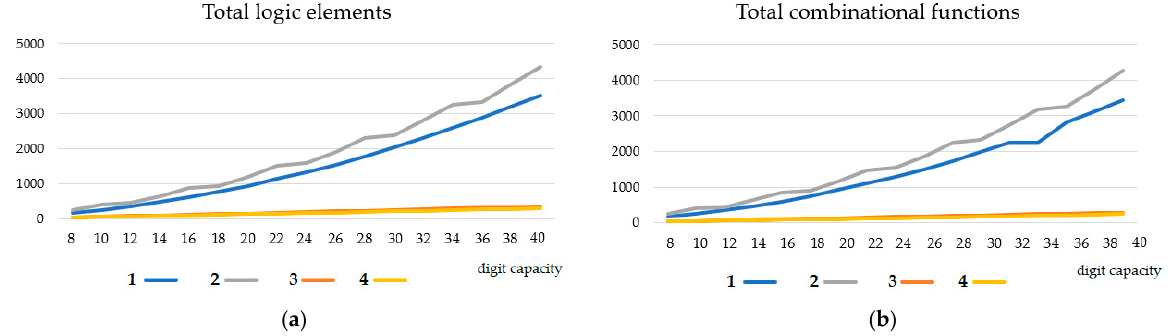
Figure 12. Hardware costs for multipliers: ( a ) total logic elements, ( b ) total combinational functions. Figure shows the following graphs: 1—two arguments by Booth’s algorithm; 2—multiplication of two arguments by the proposed algorithm; 3—multiplication by a constant by Booth’s algorithm; 4—multiplication by a constant by the proposed algorithm.